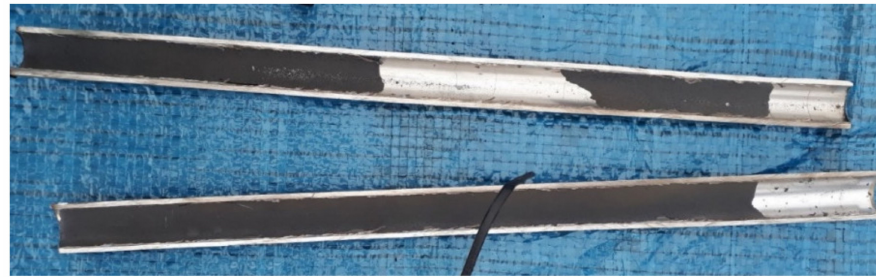
Figure 3. PbS scales deposited in tubes from the test heat exchanger.